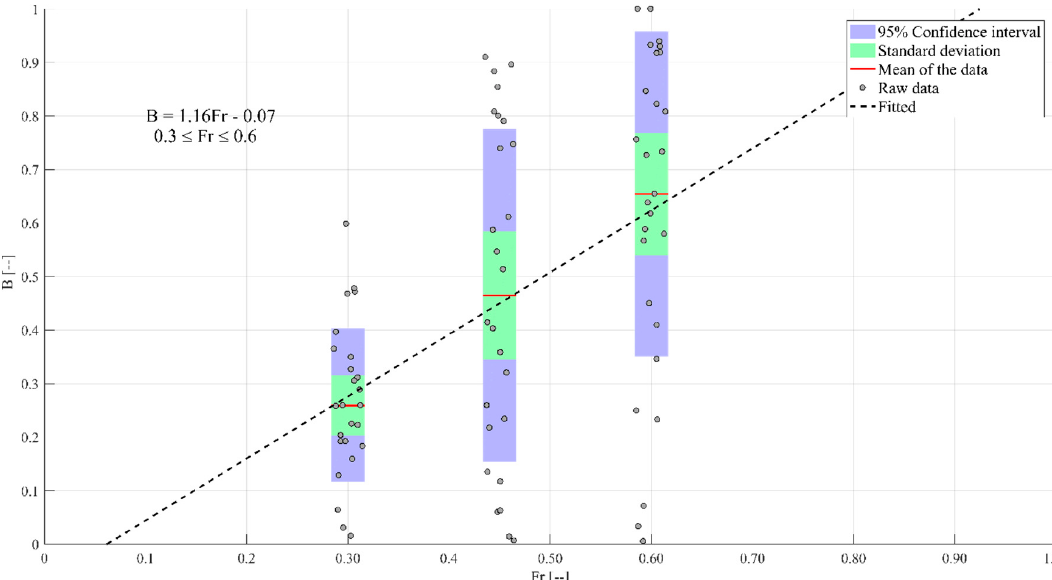
Figure 12. Blockage ratio of the dam as a function of the Froude number. All equilibrium blockage ratios are displayed as grey dots; the mean blockage ratio is displayed as a solid line.